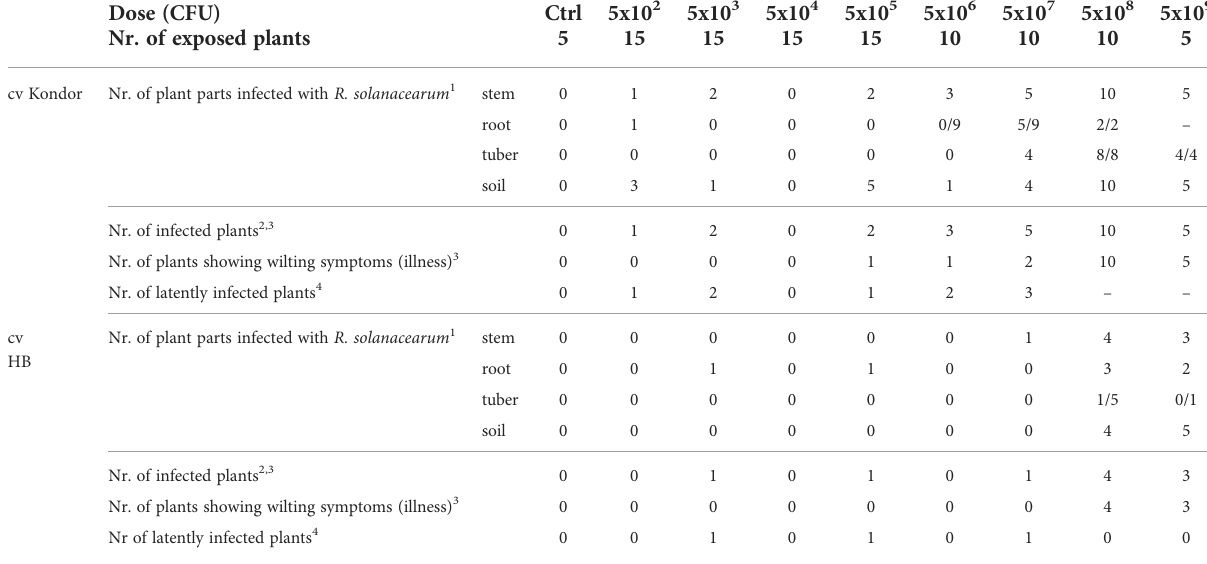
TABLE 2 Symptomatic (wilting) and non-symptomatic infections of potted potato plants cv Kondor and HB after a single non-invasive soil soak inoculation with different doses of Ralstonia solanacearum . Dose